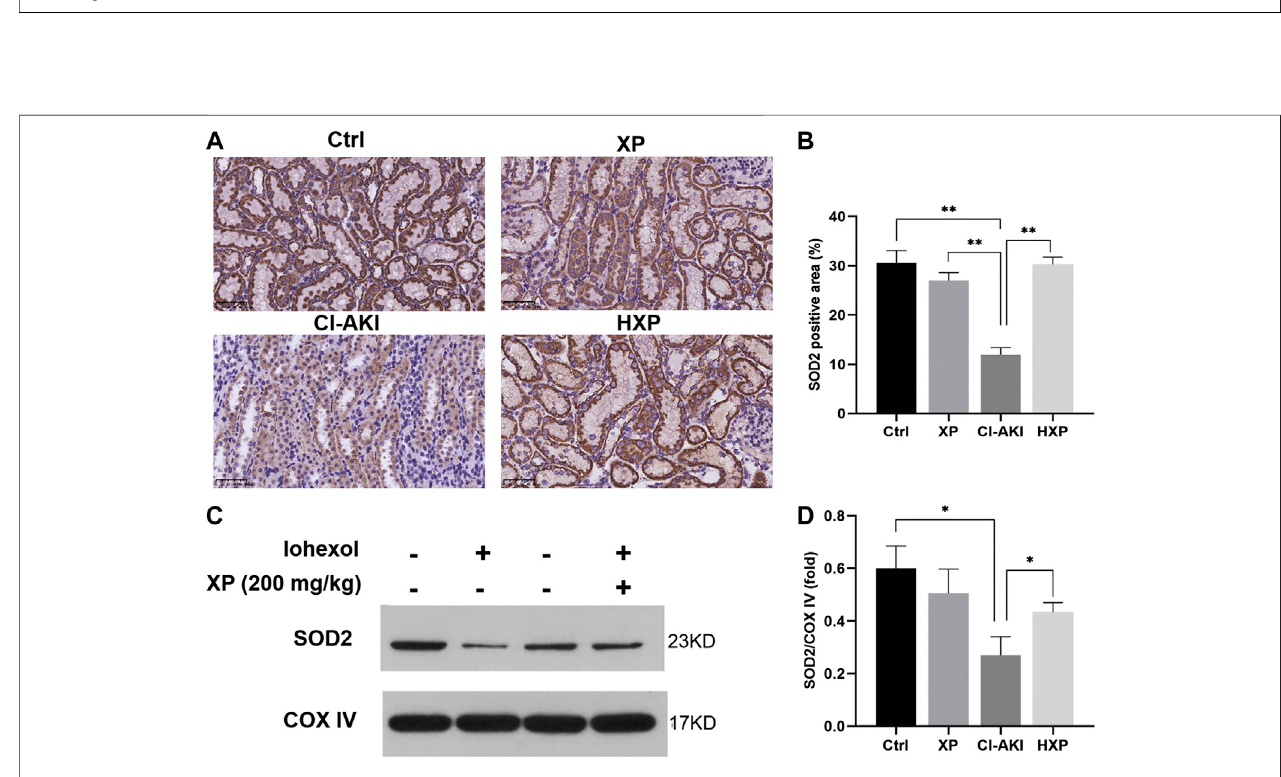
FIGURE 6 | XP treatment attenuated iohexol-induced mitochondrial dysfunction in rats. (A) Immunohistochemistry staining of superoxide dismutase 2 (SOD2) in renal tissues (Magni fi cation: × 400, Scle bars: 50 μ m). (B) The quanti fi cation of SOD2 in the four groups. (C) Western blotting analysis of SOD2 in four groups of renal tissues.COX IVwasused asaloading control. (D) Densitometricanalysis(proteinquanti fi cation) ofwesternblottingsignals using imageJ software. Foldchangeineach proteinlevelnormalizedtoCOXIVisshownnumerically.Dataarepresentedasmean ± SEM( n (cid:1) 6ineachgroup).* p < 0.05;** p < 0.01;*** p < 0.001basedonone- way analysis of variance. Representative images are presented. SOD2, superoxide dismutase two; COX IV, cytochrome c oxidase IV; Ctrl, control; CI-AKI, contrast induced-acute kidney injury; LXP, low dose XP combined with iohexol; MXP, medium dose XP combined with iohexol; HXP, high dose XP combined with iohexol.